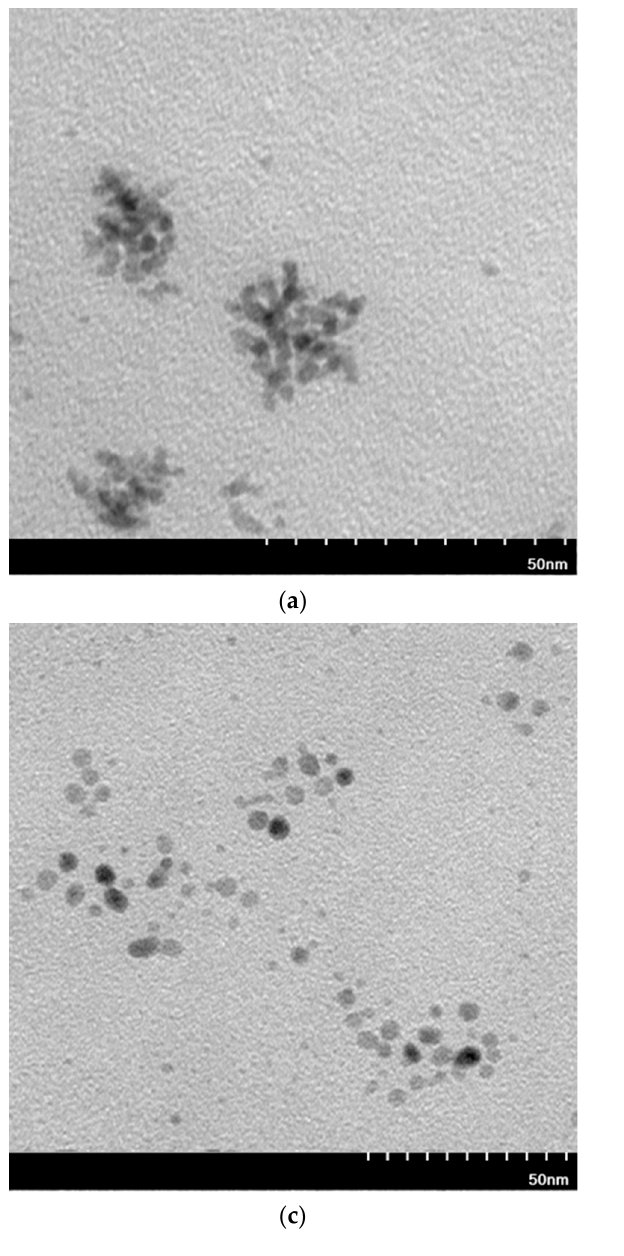
Figure 4. Transmission electron microscopy (TEM) images of Pt-NP ( a , b ) and Pd-NP ( c , d ) (the molar ratio of PGM:PVP:reducer was 1:5:2) using AA for ( a , c ) and ( c ) and NaBH 4 for ( b , d ).